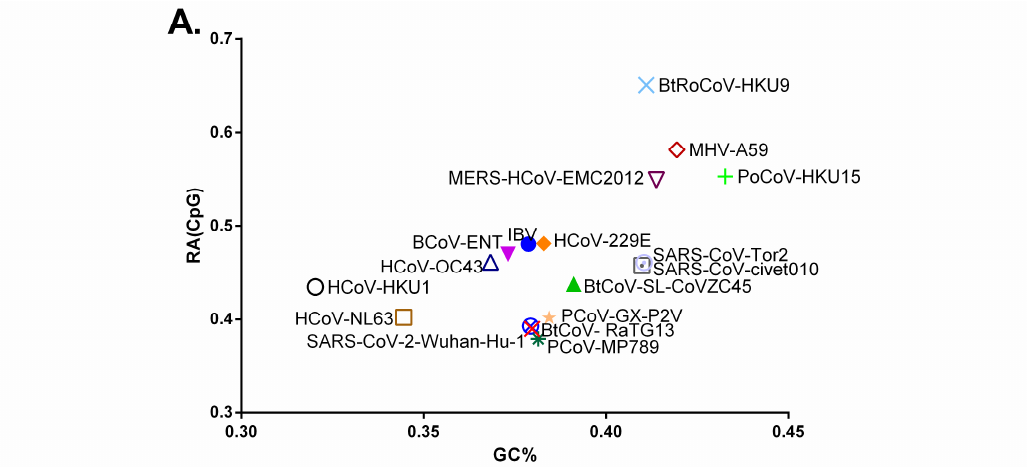
Figure 6. A plot of virus genomic RA CpG against GC% in the entire coding genomic sequences ( A ), spike ( B ), envelope ( C ), membrane ( D ), and nucleocapsid ( E ) encoding sequences of CoVs infecting diverse hosts. 3.4. Relative Synonymous Codon Usage (RSCU) Analysis Without taking amino acid compositions into consideration, the RSCU analysis es- tablishes synonymous codon usage patterns. As a result, we examined the RSCU values of chiroptera-hosted CoVs, human-hosted CoVs, and animal-hosted CoVs. We noted that, among the eight codons having CpG contents (GCG, CCG, CGA, CGC, CGG, CGU,